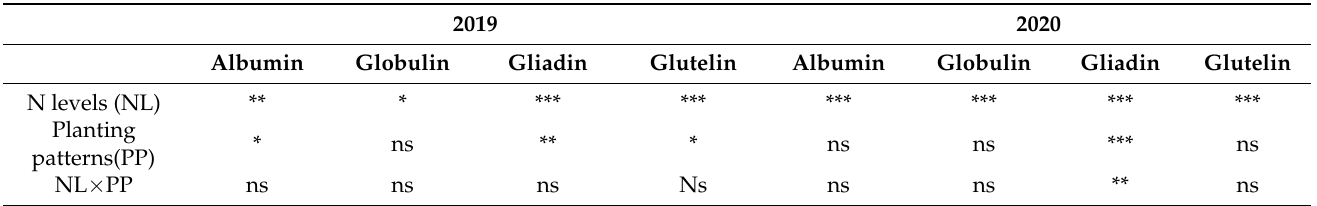
Table 2. Two-way ANOVA analysis of grain protein composition for inter- and mono-cropped wheat under different N levels.